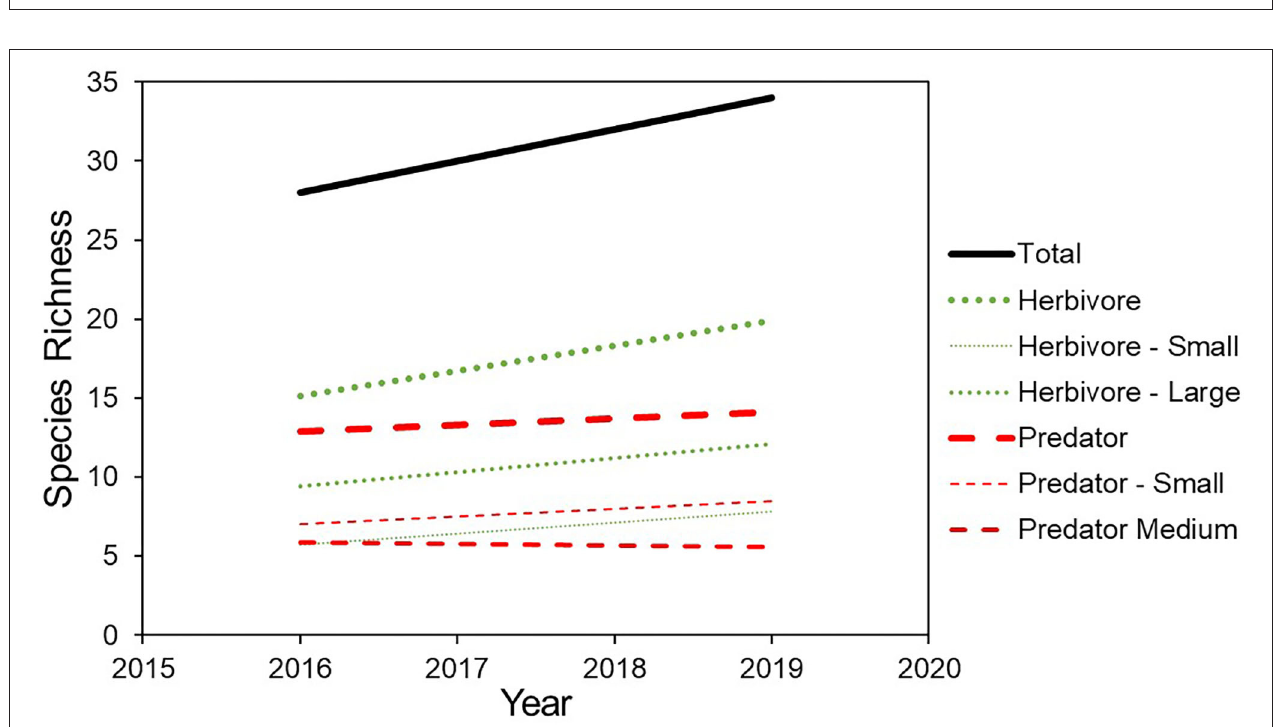
FIGURE 3 | Species richness detected on the wildlife-friendly farm per sample period and broken down by guild and body size.